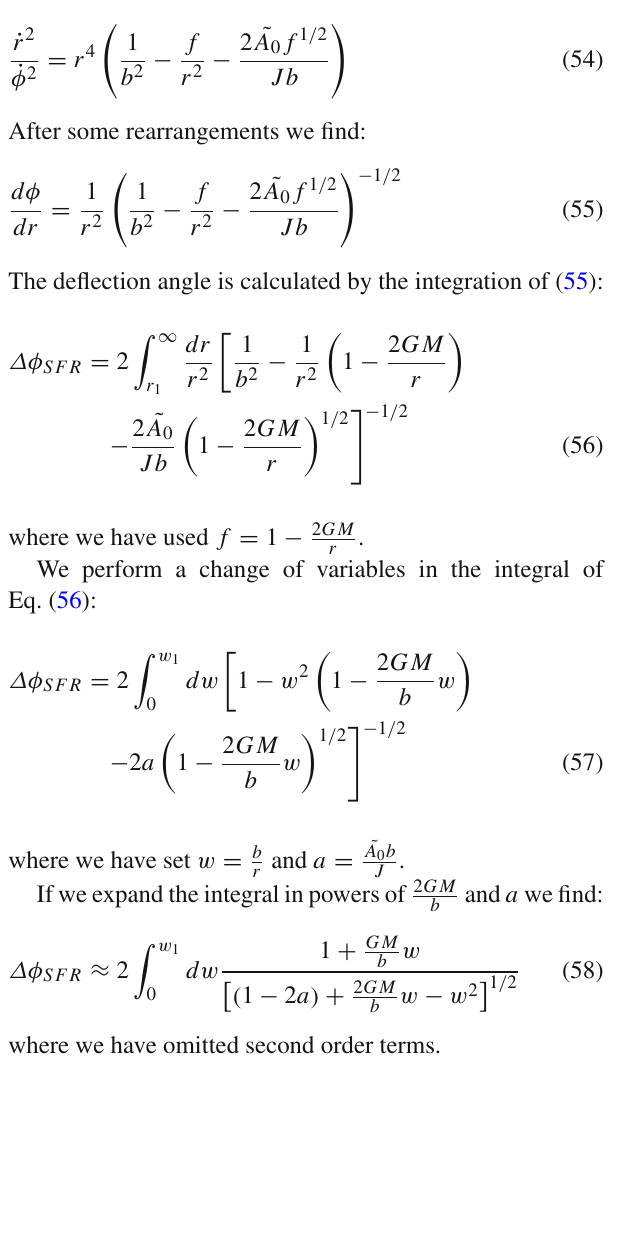
Fig. 5 This is a comparison between the radial phase portraits of the GR (blue) and SFR (yellow)